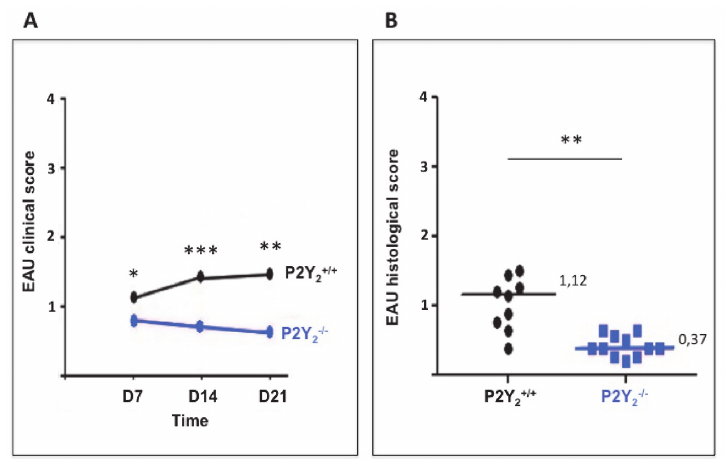
Fig 2. P2Y 2-/- mice are partially protected against uveitis development induced by the adoptive transfer of IRBP-specific enriched TL — Efferent phase. P2Y 2 +/+ (n = 9) and P2Y 2 -/- (n = 11) mice have received an adoptive transfer of semi-purified IRBP-specific enriched TL from C57Bl/6 immunized mice. Data are from two independent experiments. (A) A blind fundoscopy was performed at days 7, 14 and 21 and an EAU clinical score was established for each eye of every animal in the two groups. Data represent the median of clinical scores established for all mice at each time point. (B) At day 21, all the mice were sacrificed, the eyes enucleated and processed for histology. Hematoxylin-eosine coloration was realized in order to perform a double blind histological grading. Each symbol represents the established EAU histological score for one mouse. Lines represent median histological scores. * P < 0,05; ** P < 0,01; *** p <